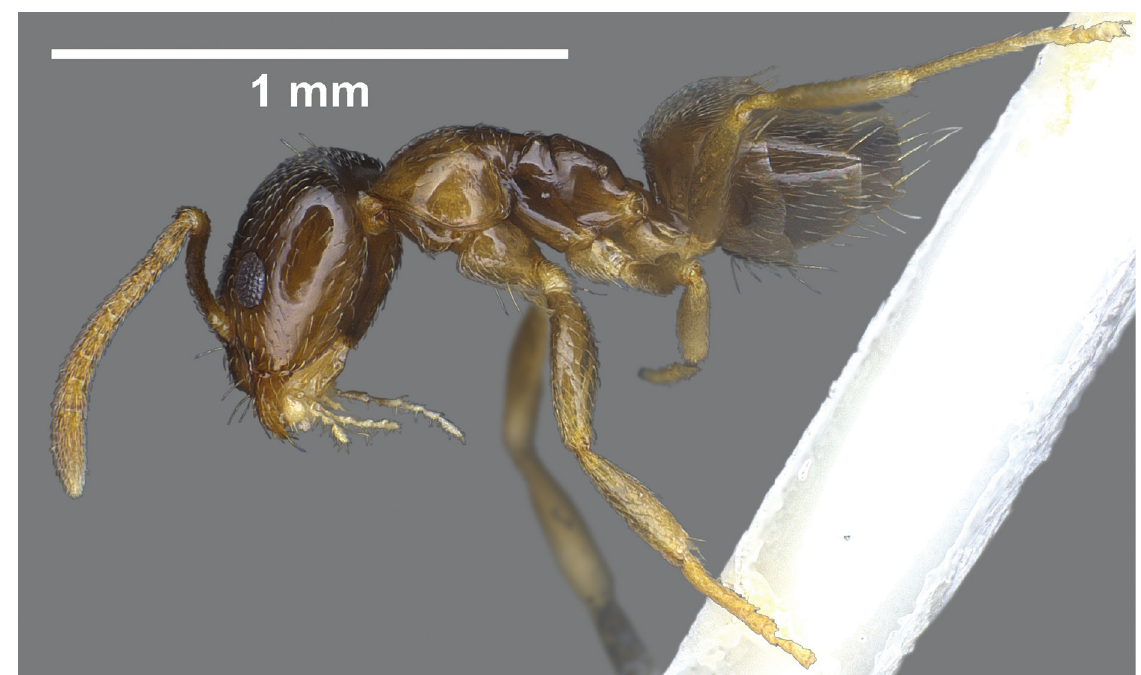
Figure 7. Lateral aspect of the holotype worker of Plagiolepis invadens sp.